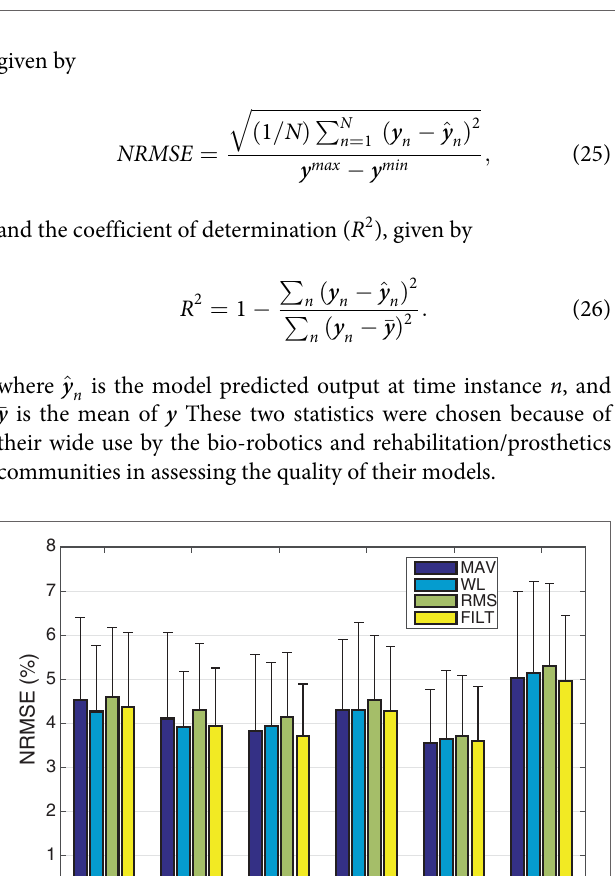
TABLE 4 | Average R 2 and NRMSE including 1 SD.